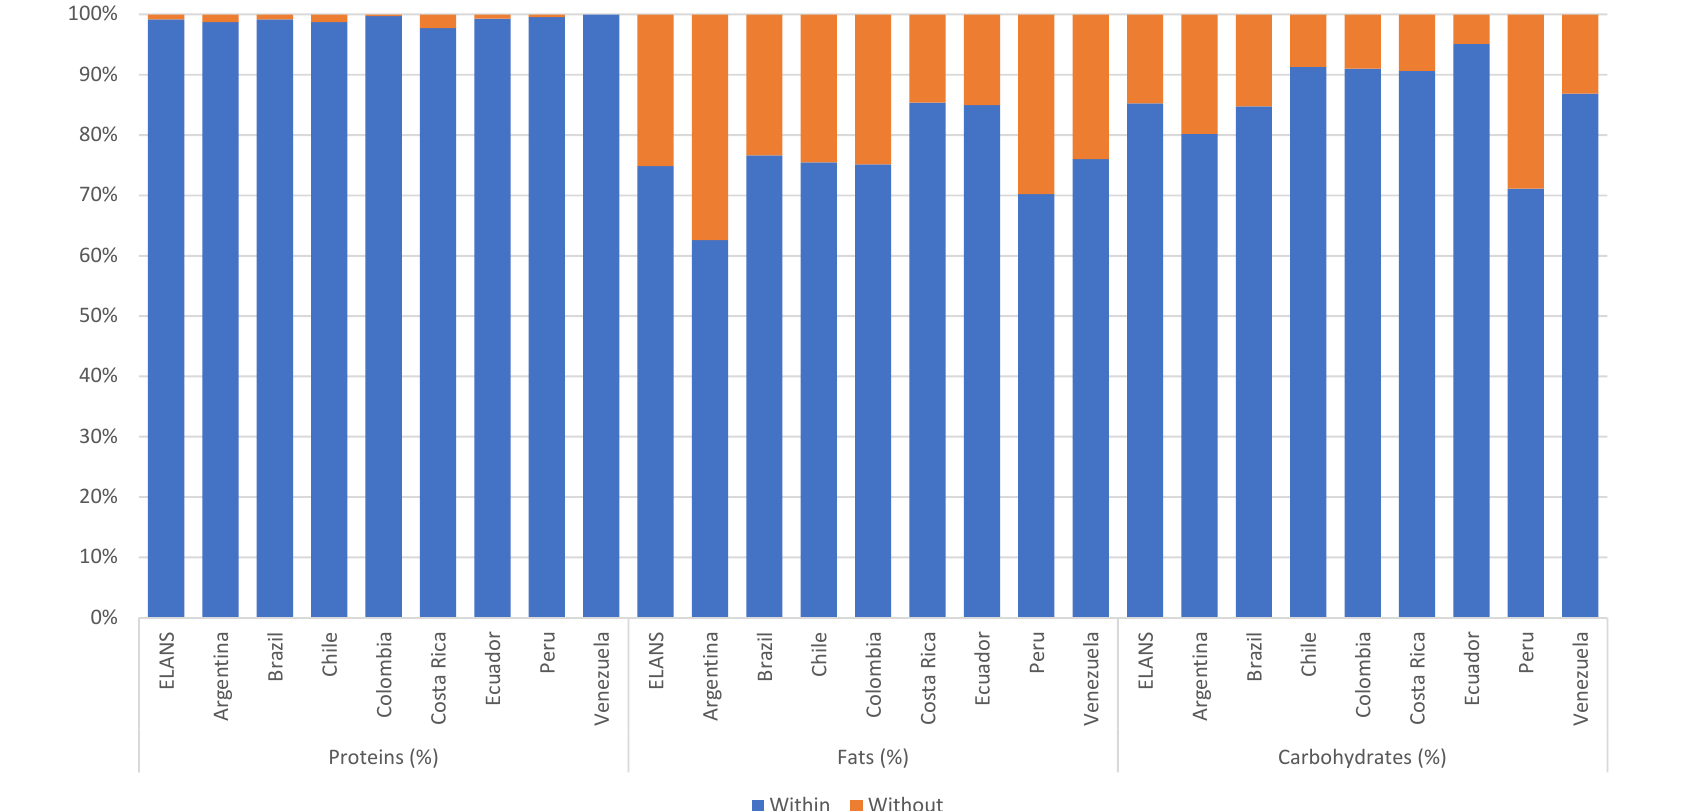
Figure 1. Percentages of individuals in relation to the acceptable percentage ranges of macronutrients among Latin American countries; Latin American Health and Nutrition Study (ELANS), 2015.